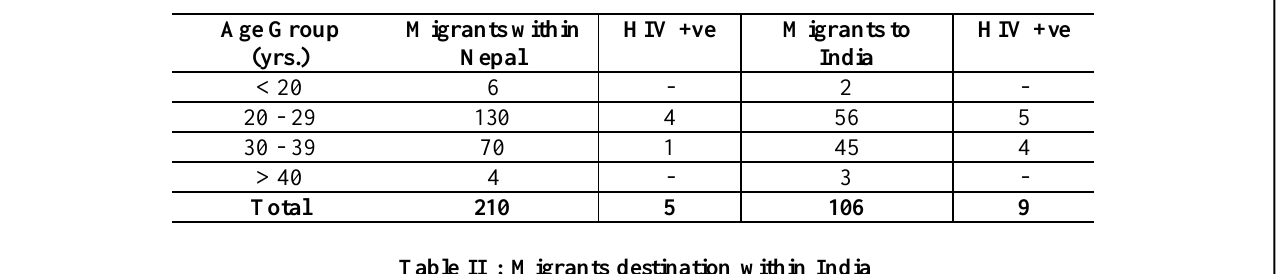
Table I : Age group distribution